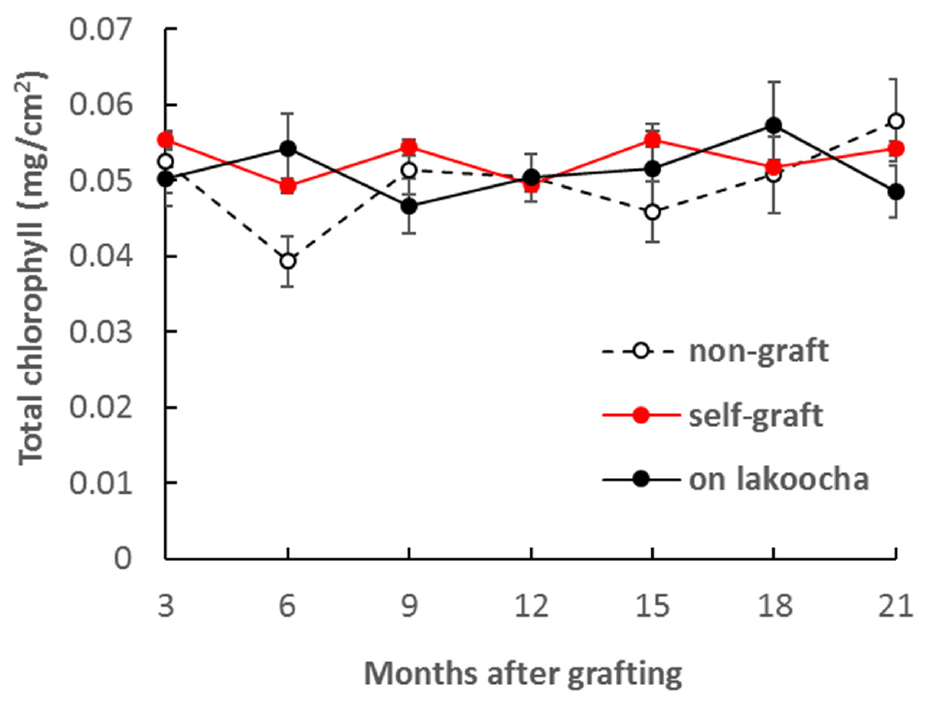
Figure 3. Total chlorophyll content of scion leaves growing on different rootstocks from 3 to 21 months after grafting. Chlorophyll contents were measured by hand-held chlorophyll meter (see Methods). All values represent mean ± SE from five biological replicates (* p < 0.05).